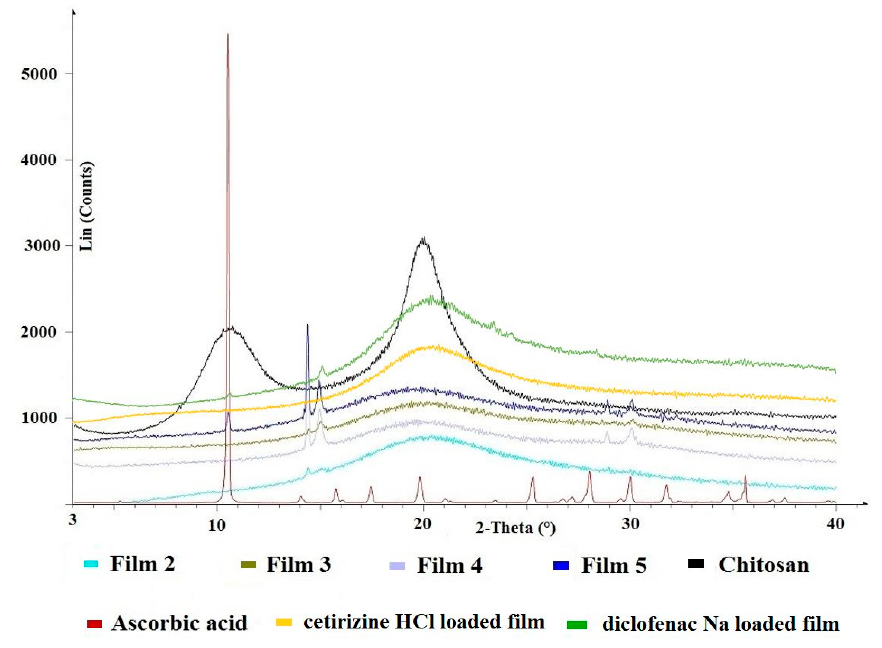
Figure 5. The XRPD results of the films.